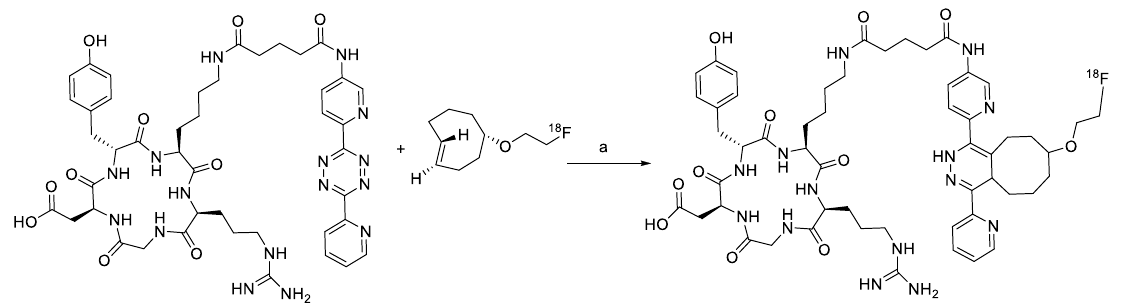
Figure 9. Radiolabeling of tetrazine conjugated cRGD peptide using 18 F-labeled TCO; a ) DMSO, 10 s, room temperature.